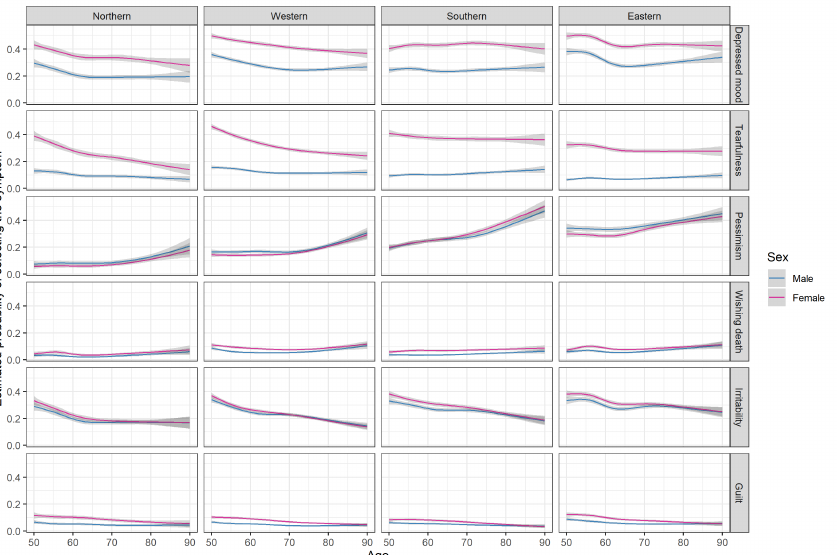
Figure 4. Estimated probability of selecting a symptom (affective, irritability and guilt). Estimates were obtained from logistic regression models including two-way interactions between age, sex and region (base model) and additional risk factors (education, BMI, current smoking, presence of chronic disease, vigorous physical activity, living arrangement; adjusted model); age was modelled using restricted cubic splines (rcs). See Table 3 for sample sizes within each region and by sex, and for descriptive